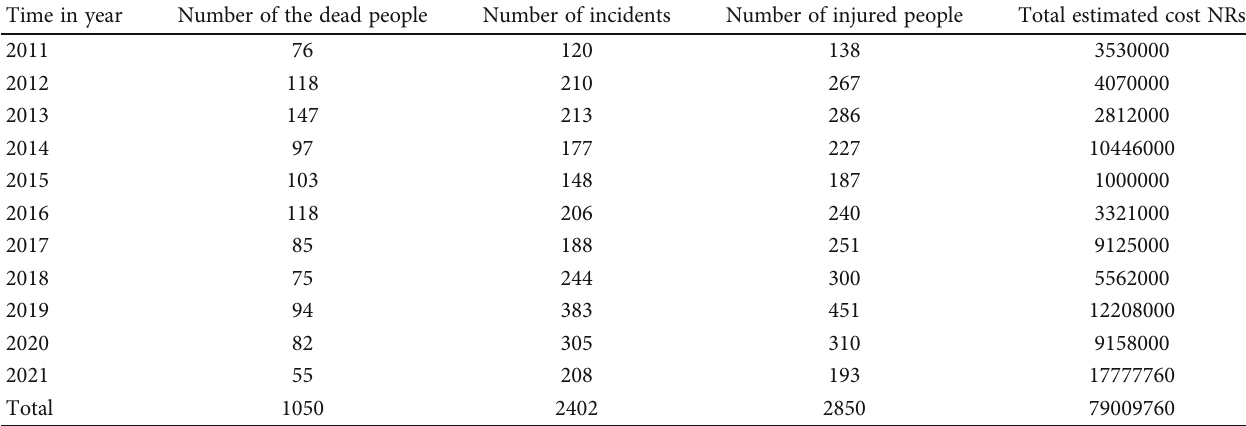
Table 2: The number of the casualty of the human beings, number of lightning events, and number of humans injured due to the lightning disaster in the Himalayan regions.